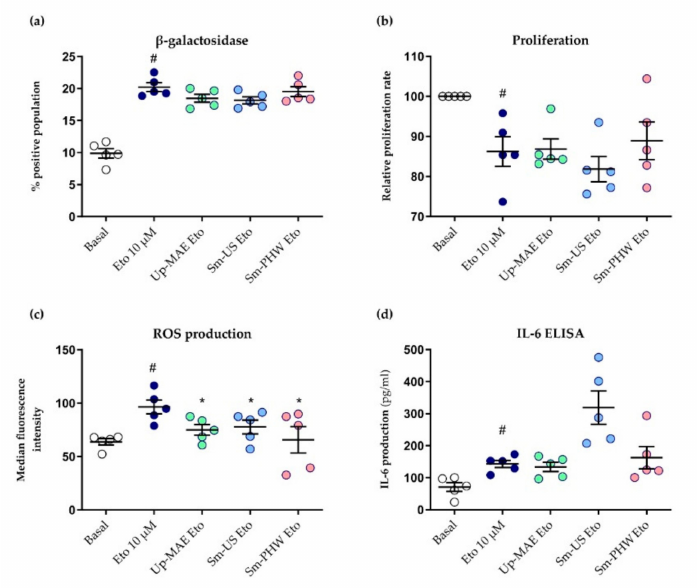
Figure 9. Effect of crude fucoidans on cellular senescence induced by etoposide in 260TT chondrocytes. Cells were treated as indicated for 48 h. Following this, ( a ) abundance of senescent chondrocytes was assessed through measurement of β -galactosidase activity by flow cytometry ( n = 5), ( b ) proliferation ratio was evaluated by BrdU proliferation assay ( n = 5), ( c ) ROS production was monitored by flow cytometry ( n = 5), and ( d ) IL-6 production was measured by IL-6 ELISA ( n = 5). Etoposide condition is statistically different from basal condition (#: p -value < 0.05). Conditions marked with * are statistically different from etoposide condition (*: p -value <